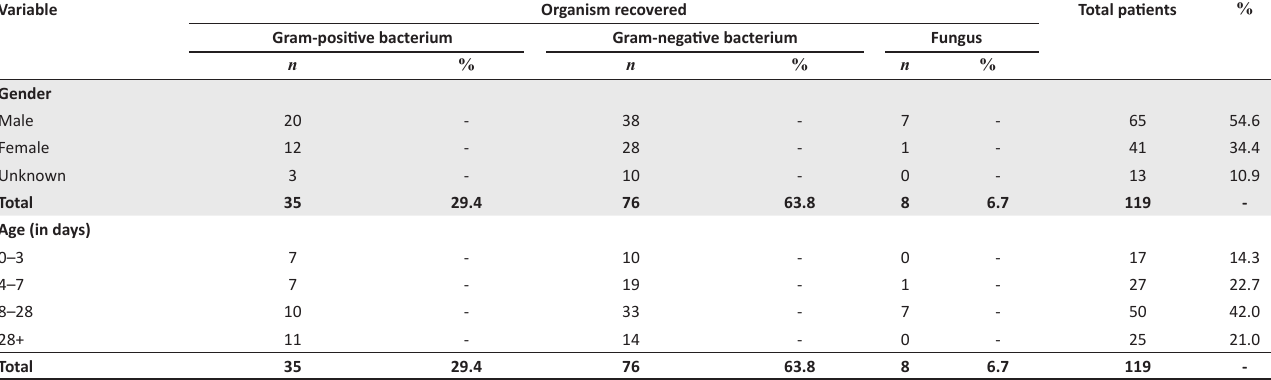
TABLE 1: Comparison of organisms in demographic groups.